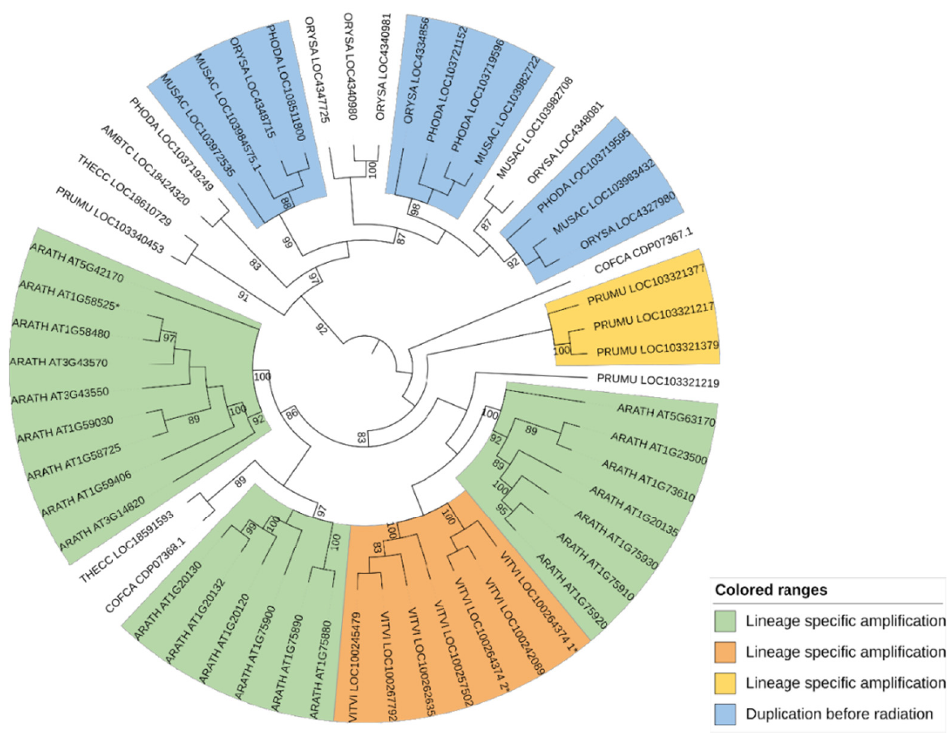
Figure 2. Phylogenetic tree in circular mode for OG-GELP-C8f rooted on node separating monocots and dicots. Colored subclusters indicate genes that originated either from duplications that occurred before species radiation (in monocots) or species-specific duplication (in dicots). Branch support with aLRT support lower than 0.8 is not displayed. * denotes curated sequences compared to automatic annotation (1* and 2* for split chimeric sequences).